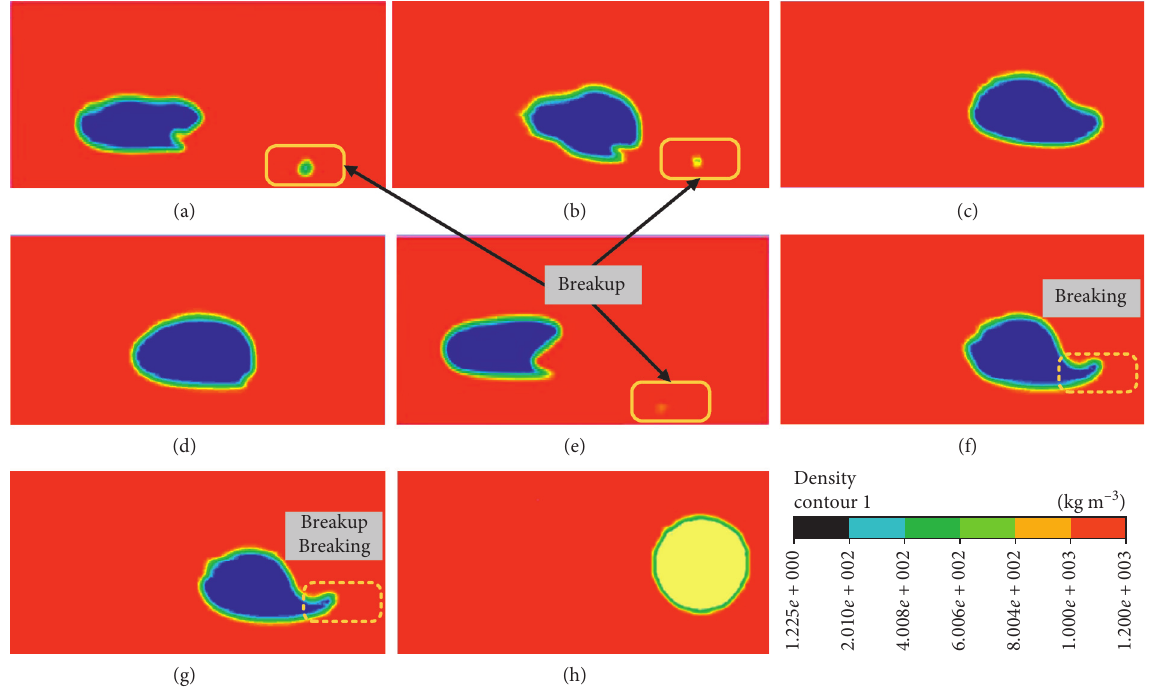
Figure 4: The behavior characteristics of bubbles and the gray recognition method under different process parameters. (a) ∼ (g) The behavior characteristics of bubbles under different AFP process parameters, where the numbers are consistent with Table 2. (a) No. 1. (b) No. 2. (c) No. 3. (d) No. 4. (e) No. 5. (f) No. 6. (g) No. 7. (h) Gray-scale recognition